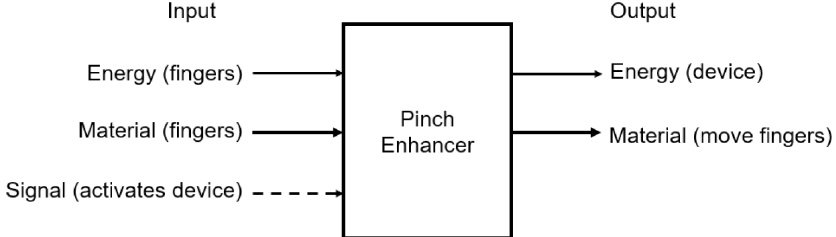
Figure 12. Functional diagram of a pinch enhancer.